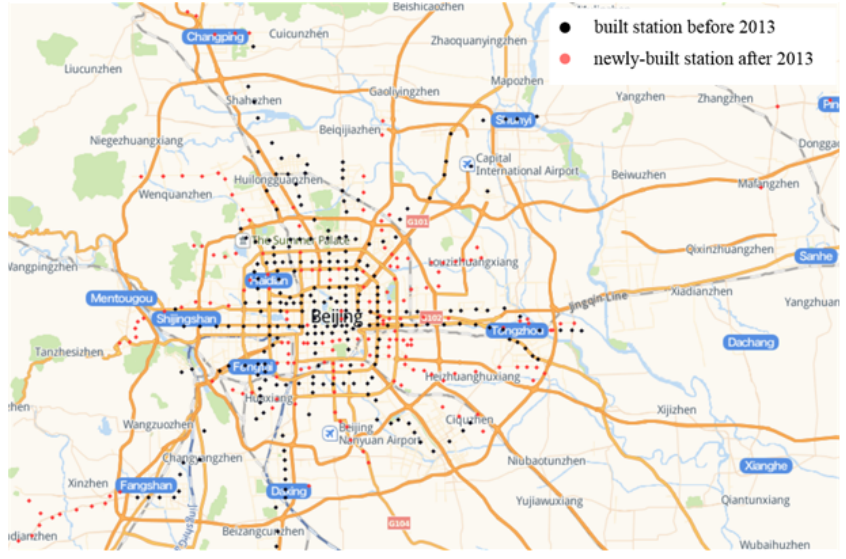
Figure 7. Comparison of Rail Transit Stations 2013 vs.